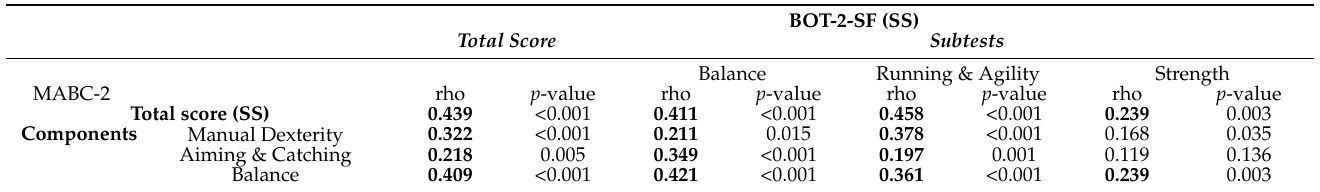
Table 5. Spearman’s rho correlation coefficients between the MABC-2 standard scores and the BOT-2-SF age adapted scaled scores.